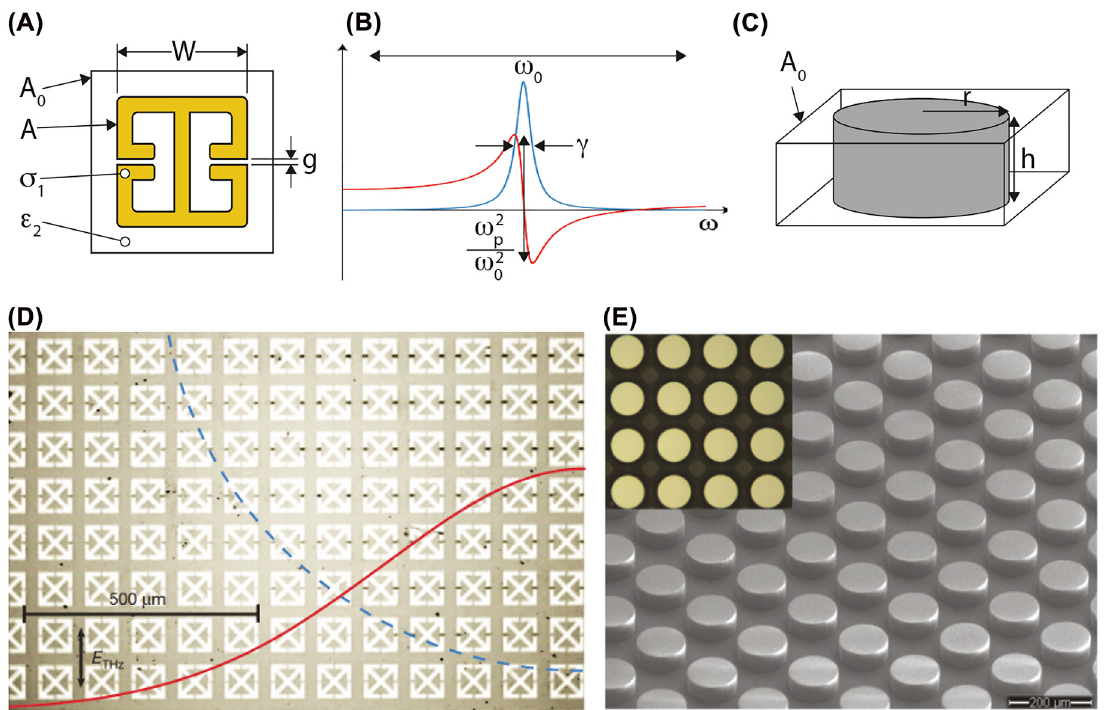
Figure 2: Geometry of metallic and dielectric unit cells that determine the resonant frequency and corresponding electromagnetic response of metamaterials. (A) and (C) Show a unit-cell of a metallic metamaterial and all-dielectric metasurface, respectively, with key geometric parameters specified. (B) A frequency dependent resonant material response in the permittivity and/or permeability is obtained from a macroscopic material fashioned from the unit-cells shown in (A) and (C). Images of a metallic metamaterial (D) and all-dielectric metasurface which is a phase (E) are shown both of which are resonant in the THz region of the spectrum. In (D) the SRR array is deposited on top of VO 2 change material exhibiting an insulator-to-metal transition at ∼ 340 K. The blue dashed line shows a quarter of the THz beam which has a Gaussian profile as indicated by the red line. The black regions in the capacitive gaps arise from electric field enhancement that is sufficient . Close inspection reveals that the damage tracks the Gaussian to drive the transition where the subsequent Joule heating damages the VO 2 beam profile. Reprinted from [54], Copyright 2012, Nature Publishing Group. (E) Reprinted from [55], Copyright 2017,